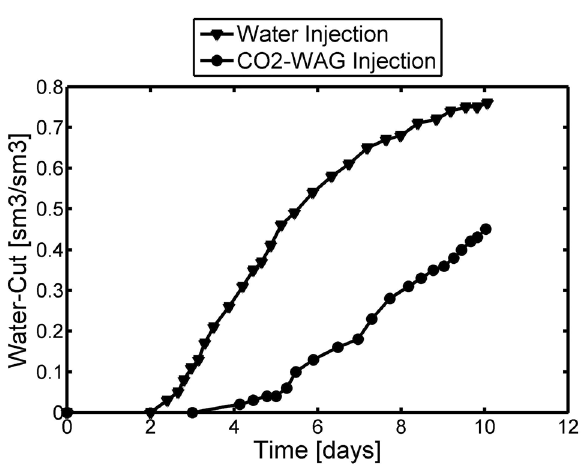
Fig. 14 Behavior of the gas-oil ratio. The curves represent the reser- voir behavior considering the contribution of all the production